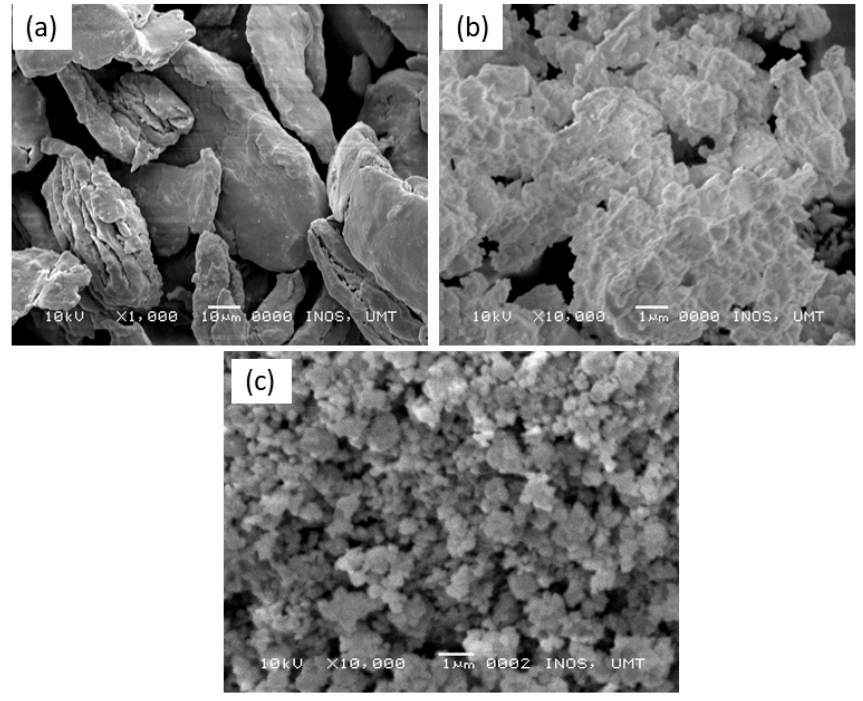
Figure 7. SEM images of ( a ) pure MgH 2 , ( b ) milled MgH 2 and ( c ) MgH 2 –10 wt.% Ni 0.6 Zn 0.4 O samples.